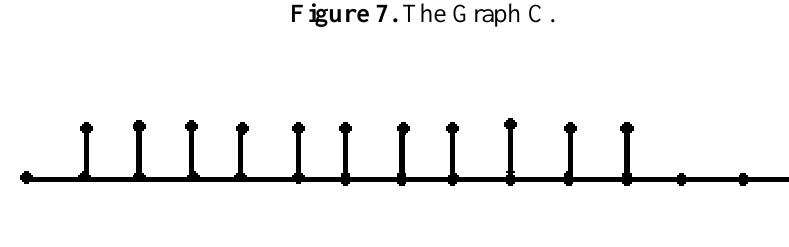
Figure 7. The Graph C.